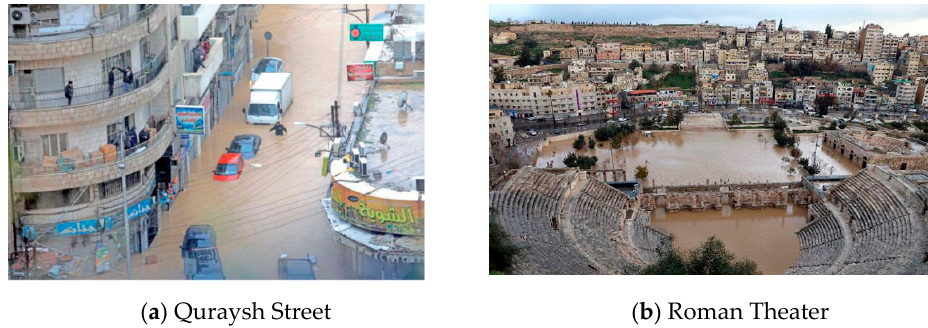
Figure 5. Downtown/Amman floods, February 2019.